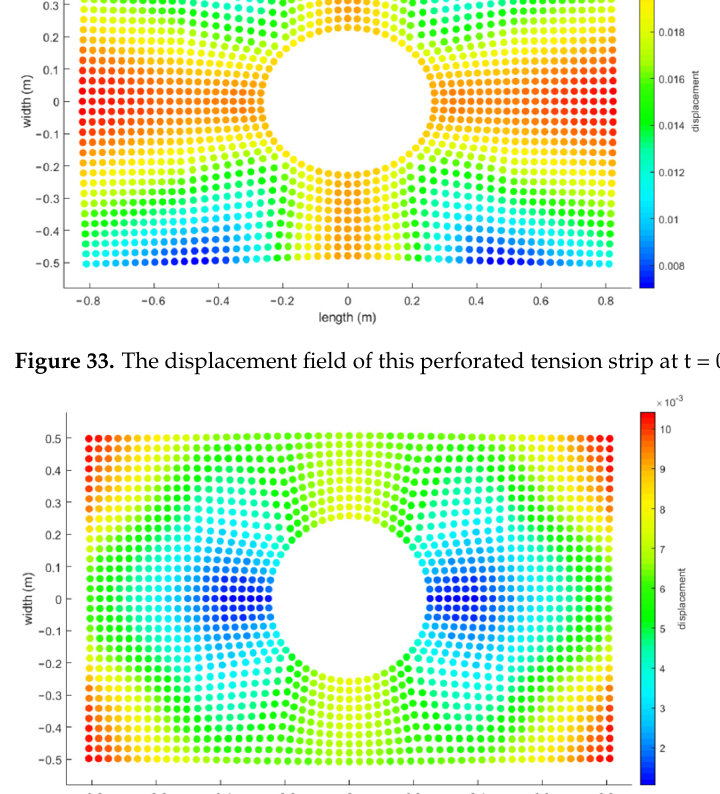
Figure 34. The displacement field of this perforated tension strip at t = 0.105 s.